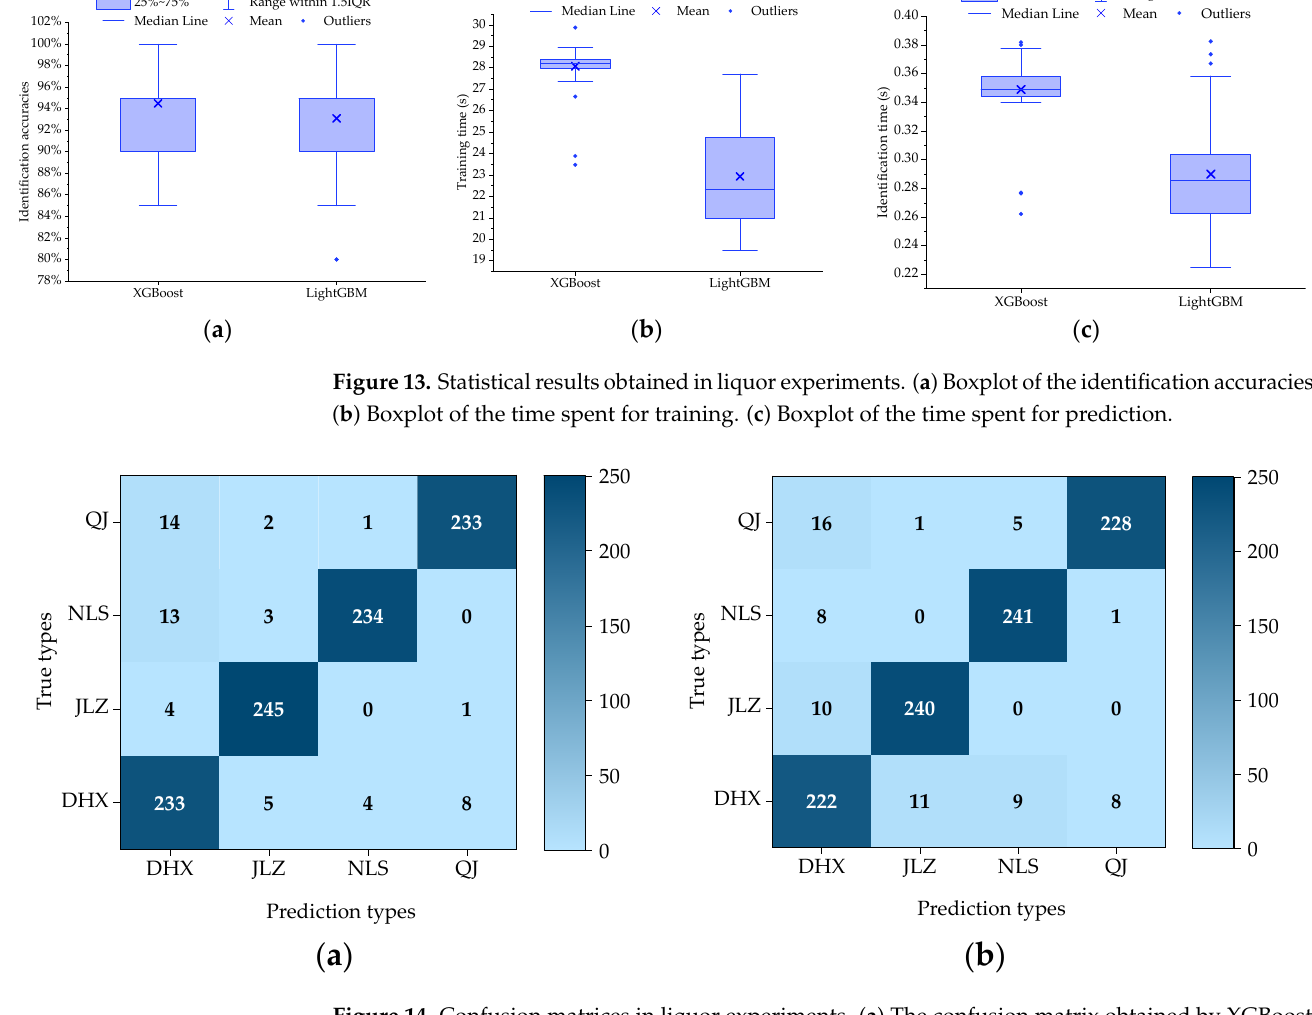
( a ) ( b ) Figure 15. The boxplot of feature importance in liquor experiments. ( a ) The feature importance ob- tained by XGBoost; ( b ) The feature importance obtained by LightGBM. Moreover, compared with the perfume experiments, the identification accuracies ob- tained in the liquor experiments are more divergent. The ranges with 1.5 × IQR of Figure 13a are 15%, which are 5% higher than those of Figure 10a. This phenomenon coincides with the relatively smaller elements of the confusion matrices in Figure 14. The relatively